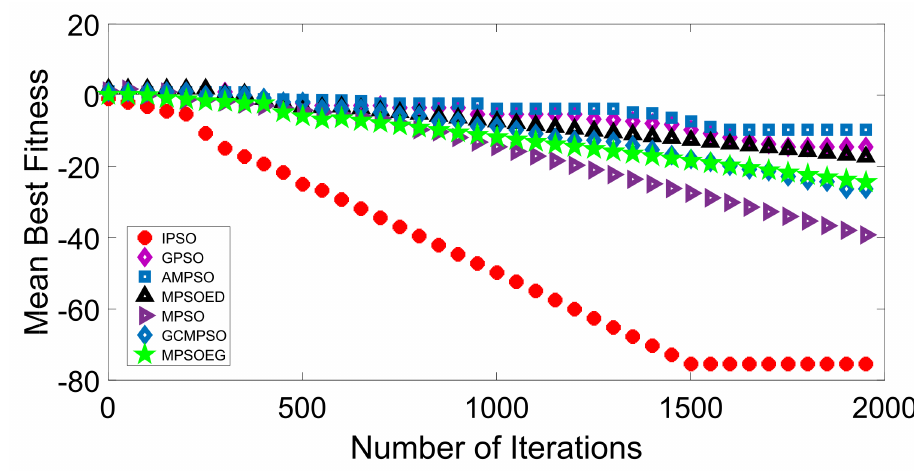
Figure A3. Algorithms’ convergence plots on f 4 .